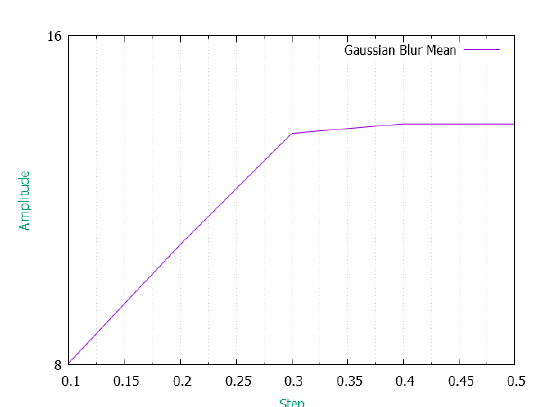
Figure 14. Plot Gaussian Blur distortion variance 64x64